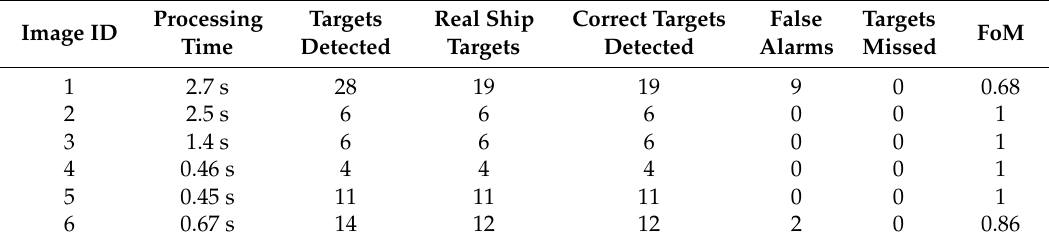
Table 4. Experimental results of the prescreening stage. FoM is the figure of